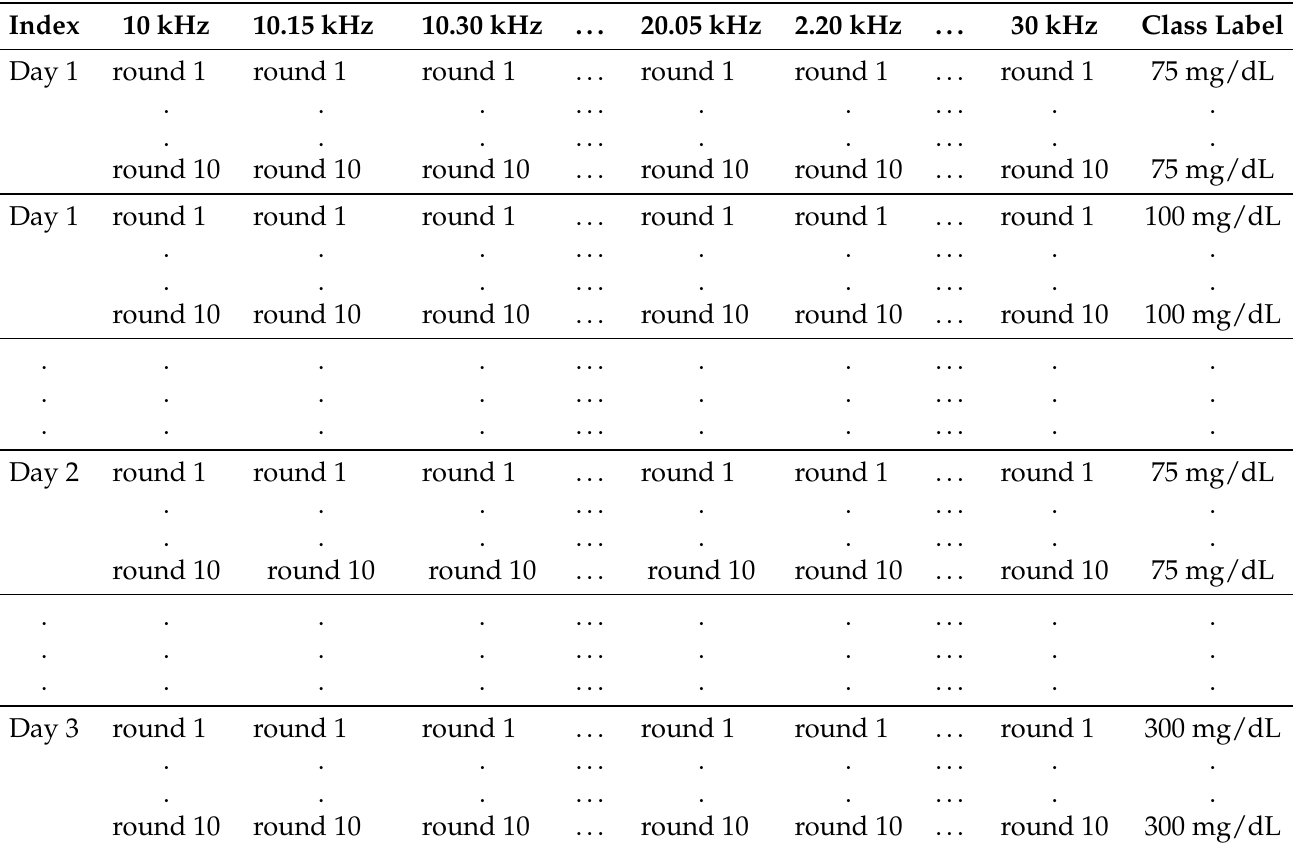
The measured acoustic spectrum for skin phantoms was classified into ten classes based on the glucose concentration of each phantom set. The first six classes cover the glucose level in the normal range (75–200 mg/dL), and the other four classes include the hyperglycemic range (225–300 mg/dL) for fasting and after eating conditions. The